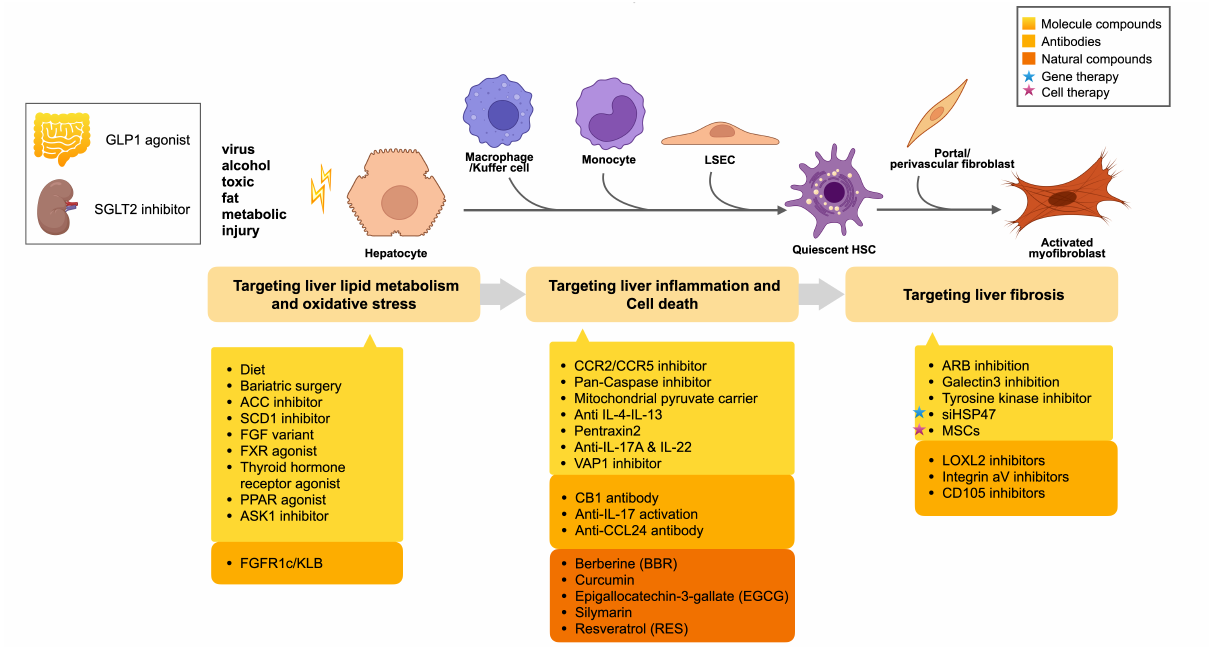
Figure 3. Therapeutic opportunities for blocking fibrosis